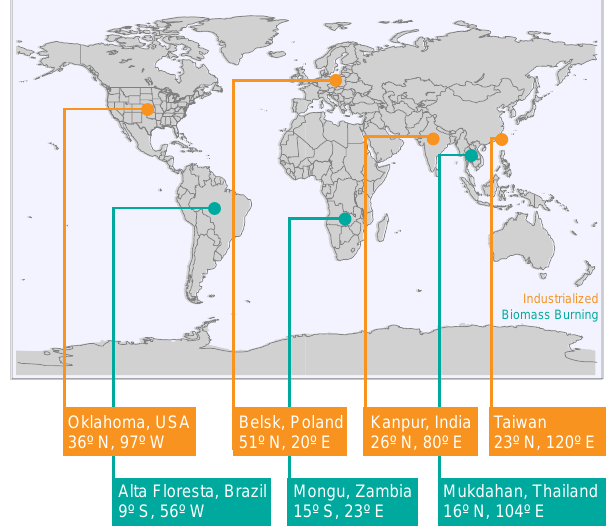
Figure 6. Map showing the locations of comparison sites.